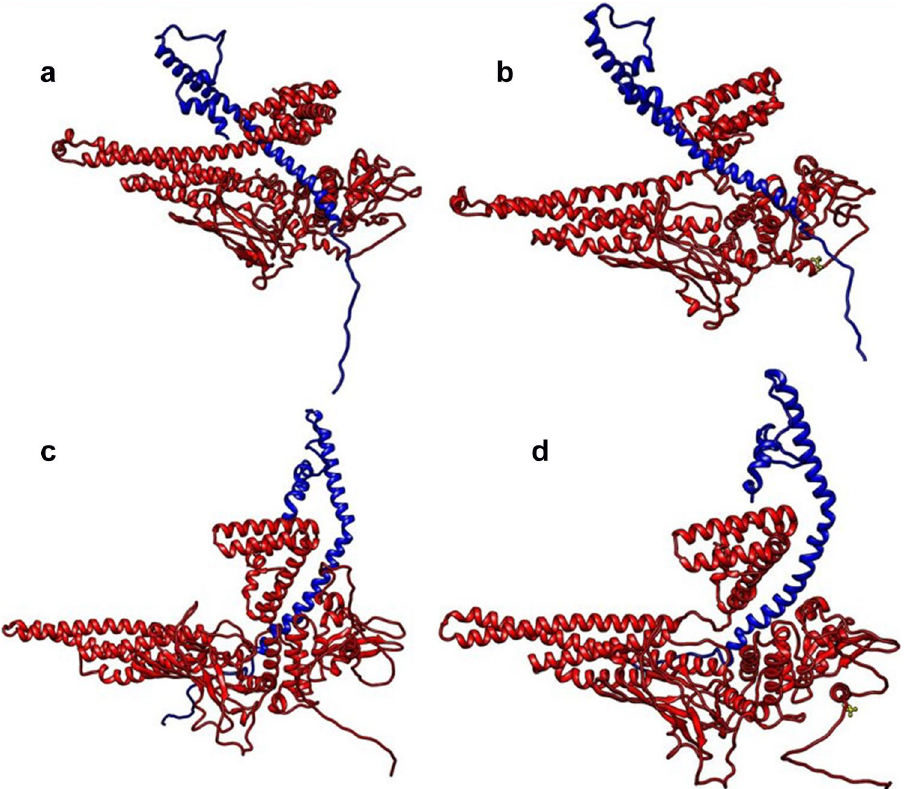
Figure 3. ClusPro2 docked complexes, ( a ) and ( b ) I-TASSER-generated STAT3; unphosphorylated and phosphorylated STAT3-GRIM-19, respectively ( c ) and ( d ) AlphaFold2-generated STAT3; unphosphorylated and phosphorylated STAT3-GRIM-19, respectively. STAT3 in red and GRIM-19 in blue, phosphoryl group on Ser727 is seen as ball and stick representation in yellow in b and d